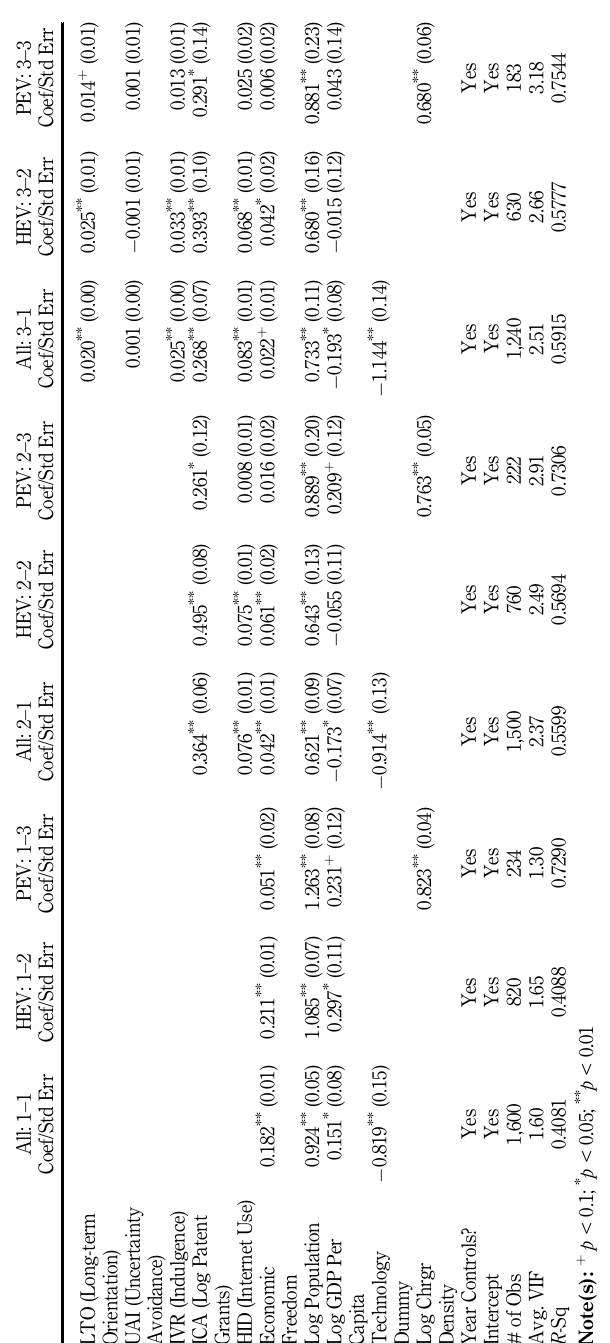
Table 3. Regression analyses